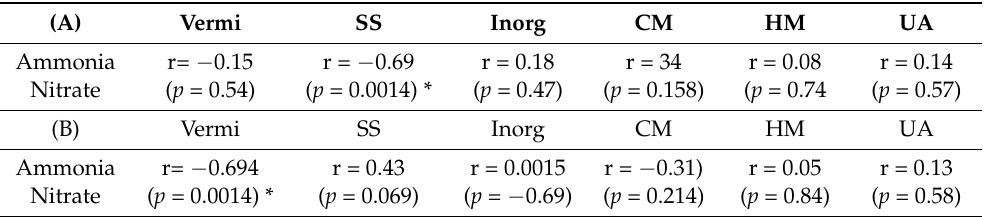
Table 3. Overall Pearson’s correlation coefficients (r) and probability of significance ( P ) between ammonia and nitrates concentrations in turnip plants (root and shoot) grown in soil treatments treated with biochar (A) and soil treatments not treated with biochar